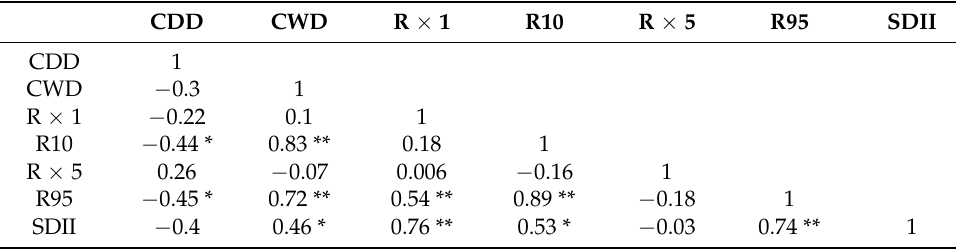
Table 2. Mutual correlation coefficients between precipitation climate change indices. * is 0.05 significance, and ** is the 0.01 significance